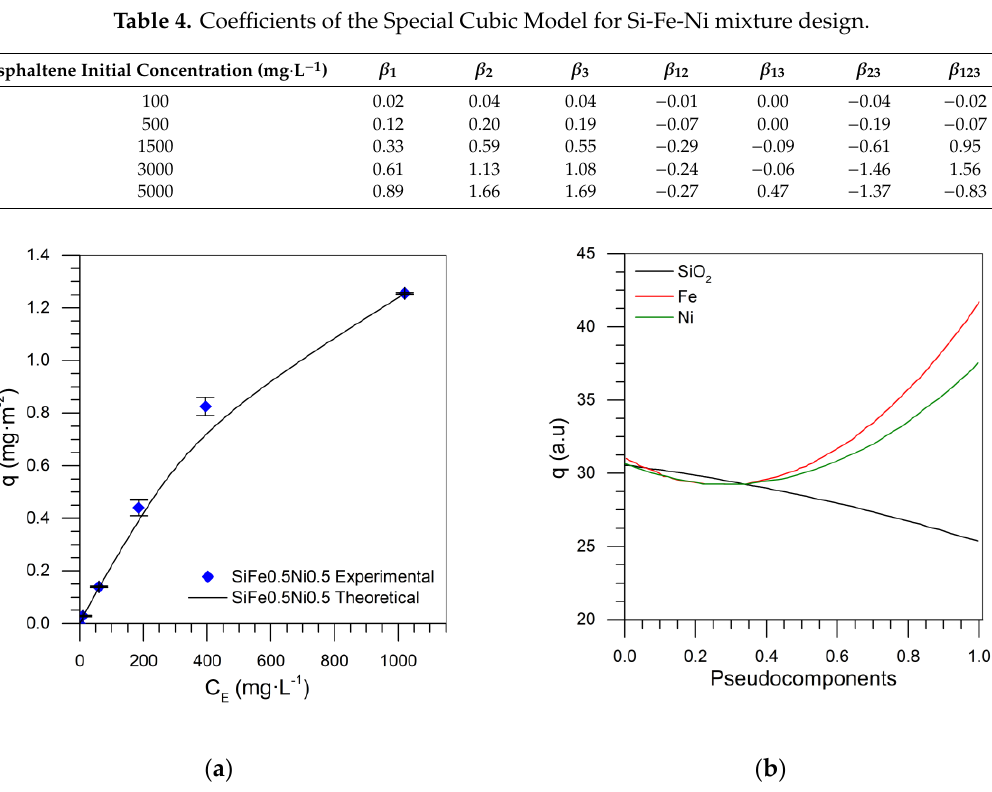
Figure 6. ( a ) Asphaltene sorption isotherm at 25 °C for SiFe0.5Ni0.5, experimental and theoretical data, and ( b ) trace plot at 100 mg·L-1 for Si-Fe-Ni mixture design .